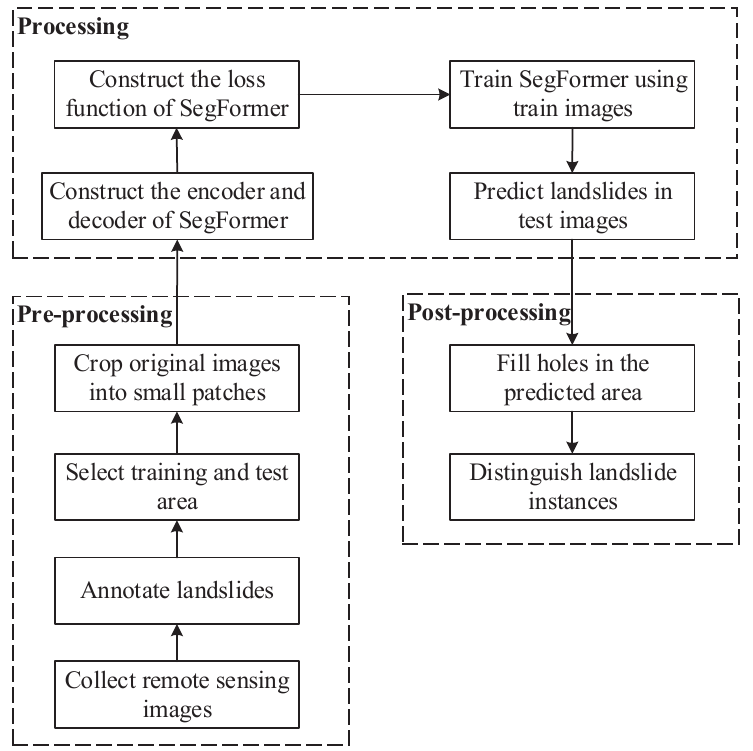
Figure 2. The pipeline of coseismic landslide detection using